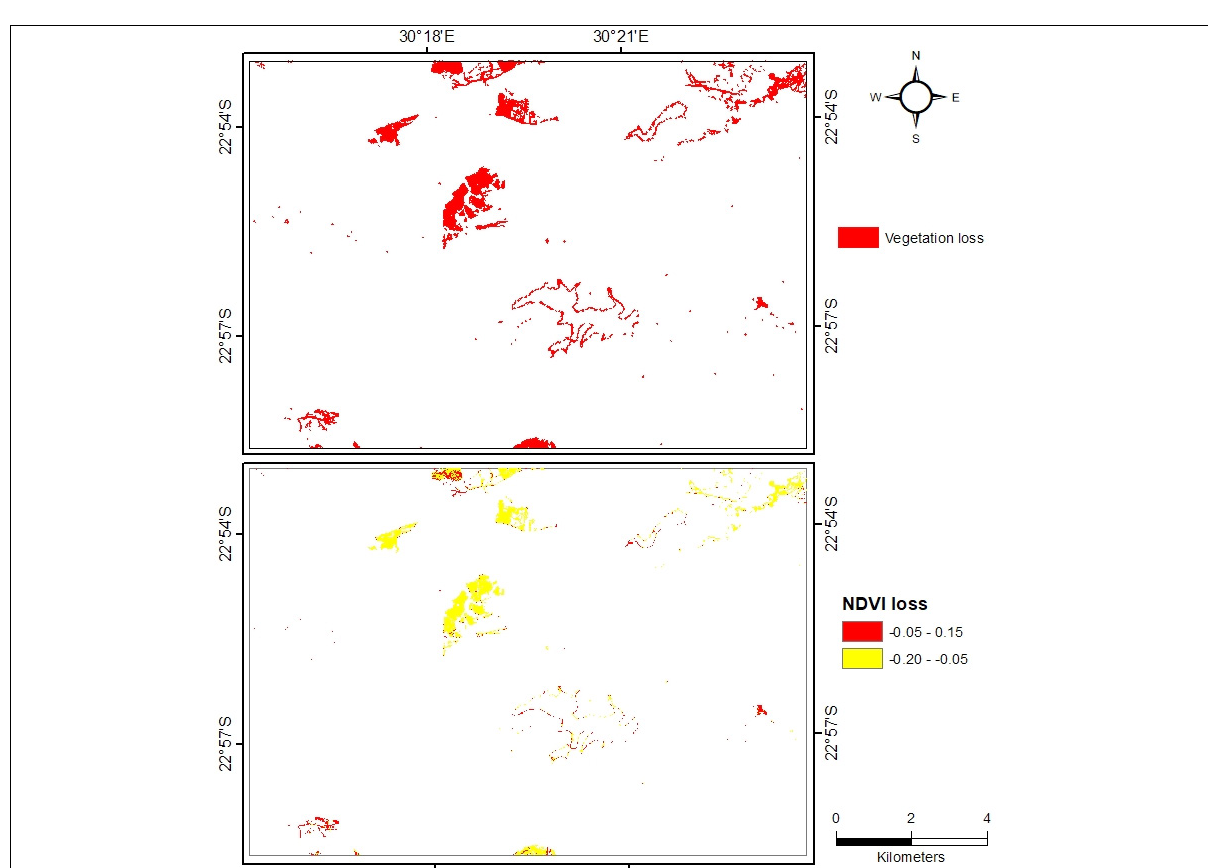
Figure 10: Vegetation loss vs Normalised Difference Vegetation Index (NDVI)